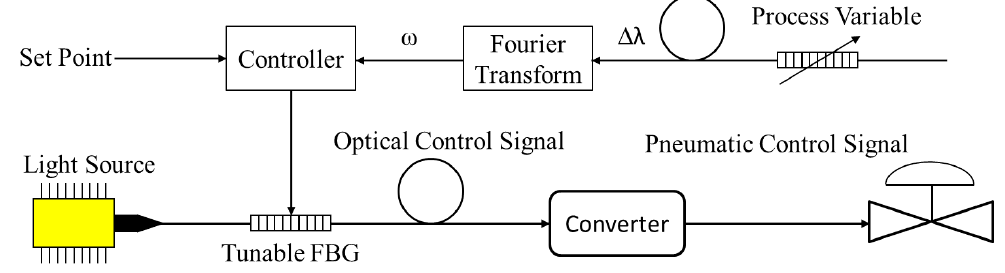
Figure 5. Schematic of an All Optical Control System (AOCS). Reproduced with permission from [122], Copyright IEEE,